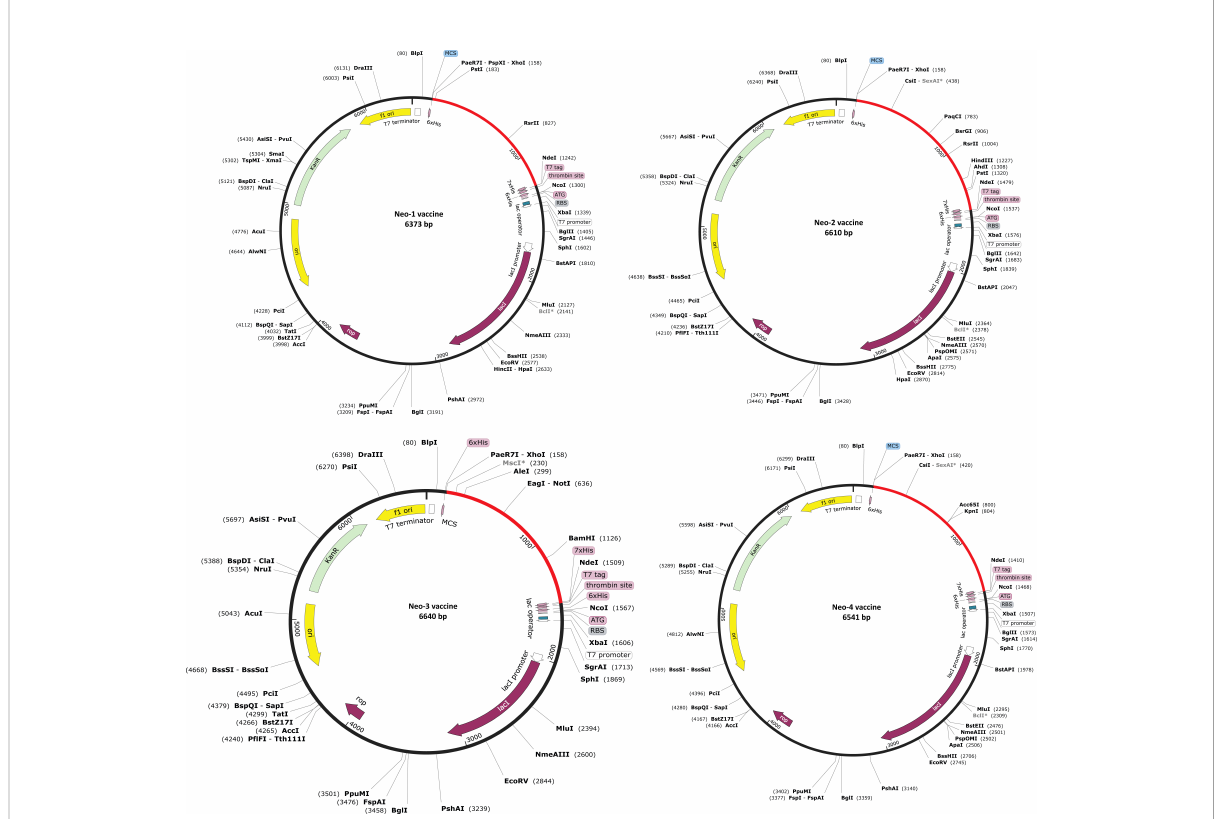
FIGURE 6 In silico restriction cloning of Neo-1 − 4 vaccine constructs. Using the SnapGene program, the fi nal vaccine constructs codon-optimized sequence (red color) was cloned between the XhoI (158) and NdeI (936) restriction enzyme loci in the pET-28a (+) expression vector (black color). Ef fi cient expression of the designed constructs can be carried out in E. coli strain K12 for effective vaccine